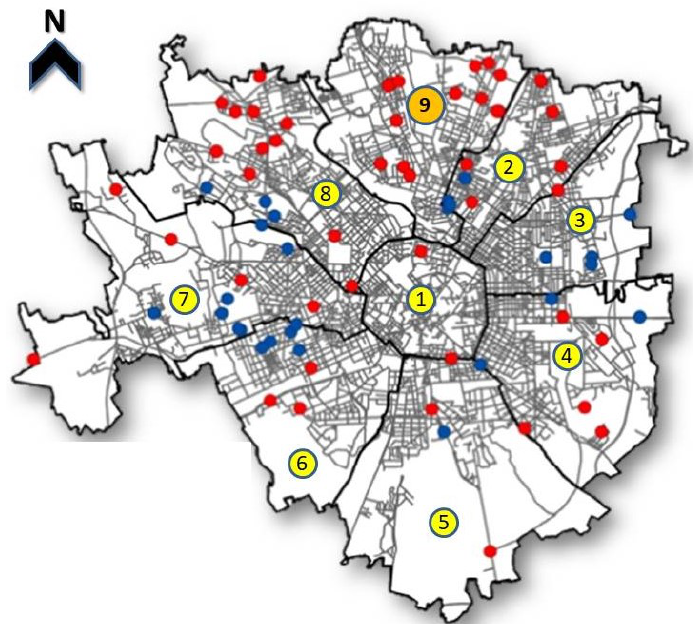
Figure 1. The nine urban zones in the city of Milan (numbered within circles). The zone of interest in this work that is our pilot zone is the 9th Zone (Z9). The red and blue full circles indicate the locations of traffic noise measurements performed during two different measurement campaigns [68].